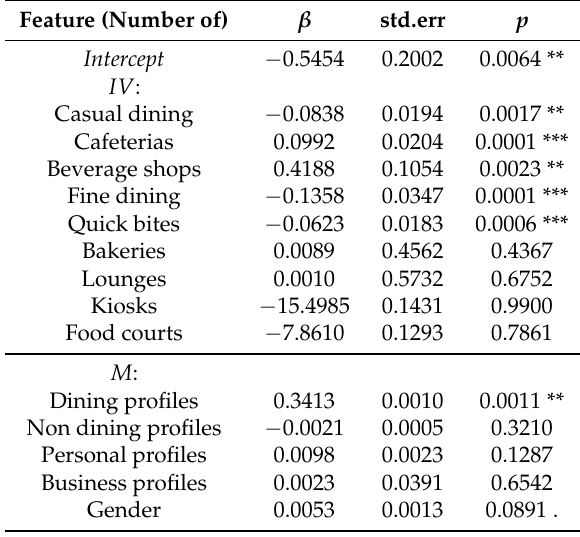
Table A2. Summary of regression results of mediation analysis: independent variables ( IV ), mediator variable ( M ) and dependent variable ( DV ) being dining posts made during the afternoon ( DV afternoon ) between 12:00 p.m. and 6:00 p.m. The results for IV are presented with Dining profiles as the mediator variable.